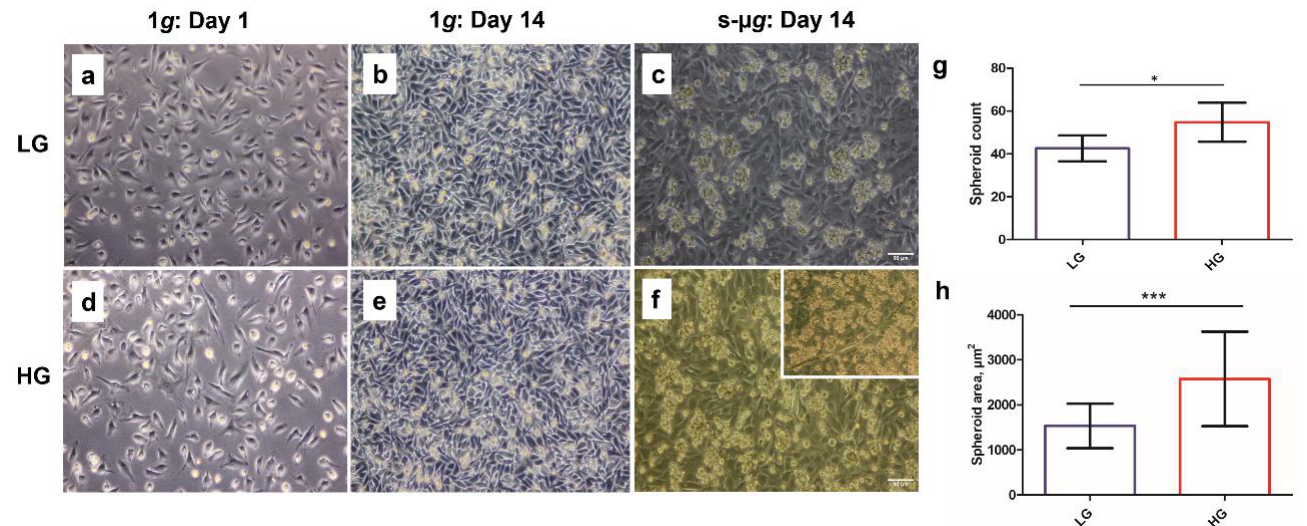
Figure 1. Morphological characteristics of EA.hy926 cells after exposure to low (LG) and high glucose (HG) media, and static normogravity (1 g ) or simulated microgravity (s- µ g ) through phase contrast microscopy ( a – f ). Adherent cells (s- µ g -AD) and multicellular structures (s- µ g -MCS) in s- µ g samples can be observed ( c , f ). The insert in ( f ) shows another sample with a tubular structure. The scale bar represents 90 µ m. The quantification of the spheroid number ( g ) and the relative spheroid size ( h ) are displayed. The spheroid size was determined via the spheroid area ( µ m 2 ). Significant changes in spheroid number or spheroid size are indicated by * ( p < 0.05) or *** ( p < 0.001), respectively. Evaluation of the number and size of spheroids in LG and HG s- µ g samples revealed that there were significantly more spheroid structures in the HG group compared to the LG group. Additionally, the spheroid size was significantly increased in the HG s- µ g samples as opposed to the LG s- µ g samples (Figure